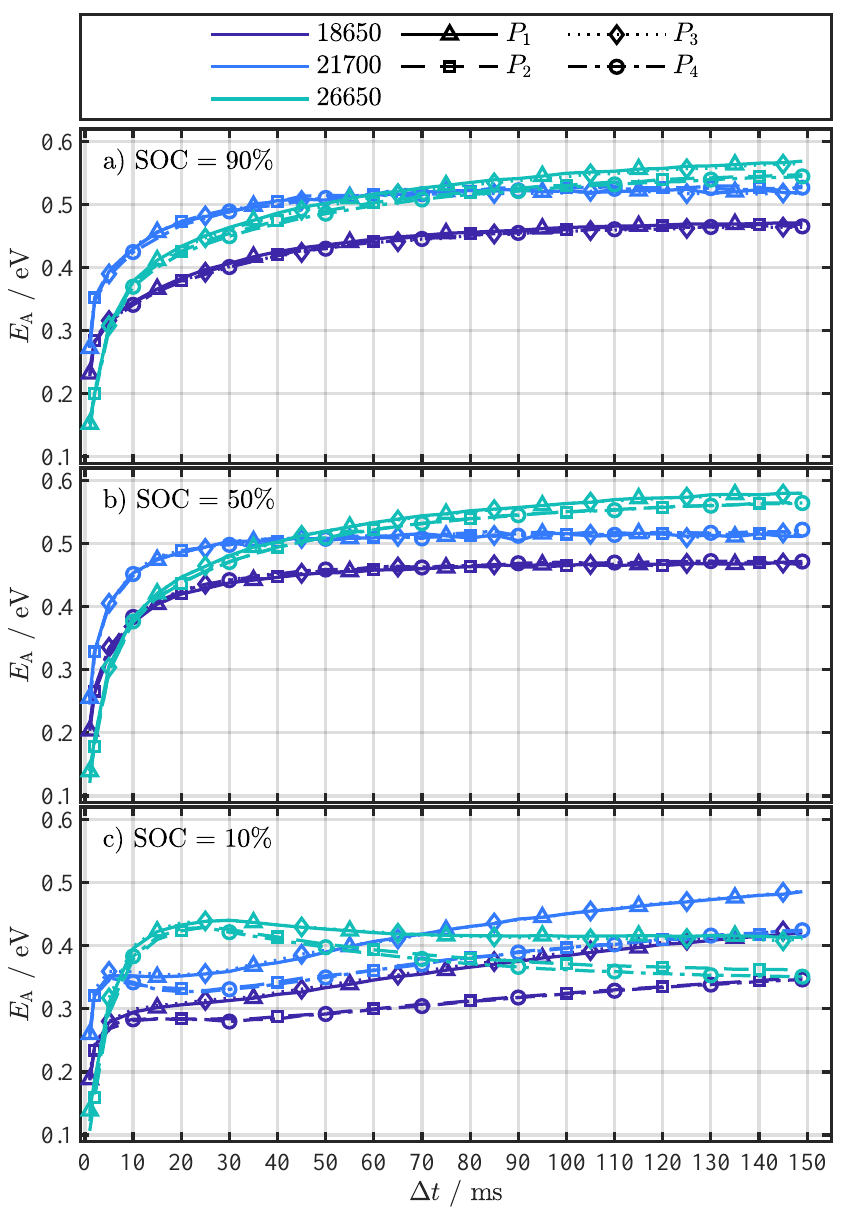
Figure A2. Fitting results for Equation (4) for the parameter E A , each investigated cell format, and the four different pulse current types ( P 1 to P 4 ) at the SOCs 90% ( a ), 50% ( b ), and 10% ( c